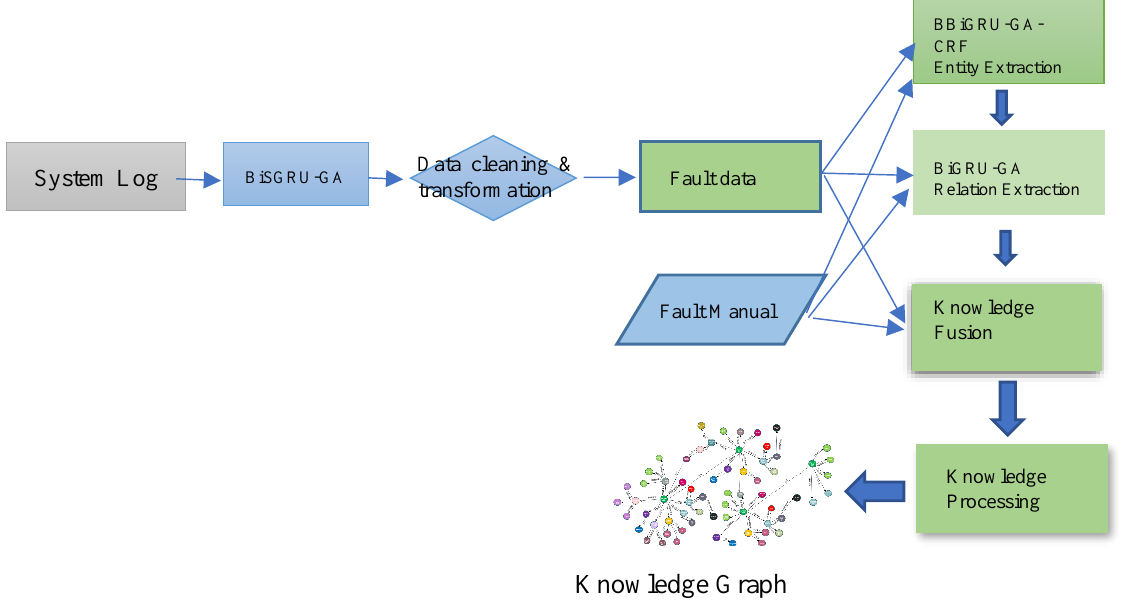
Figure 9. Power system fault diagnosis knowledge graph (part). Distribution line failure Human factor failure Natural disaster failure Frost and dew Earthquake A lightning strike Vehicle collision pole Civil constructio n damageWire suspen sion foreign body